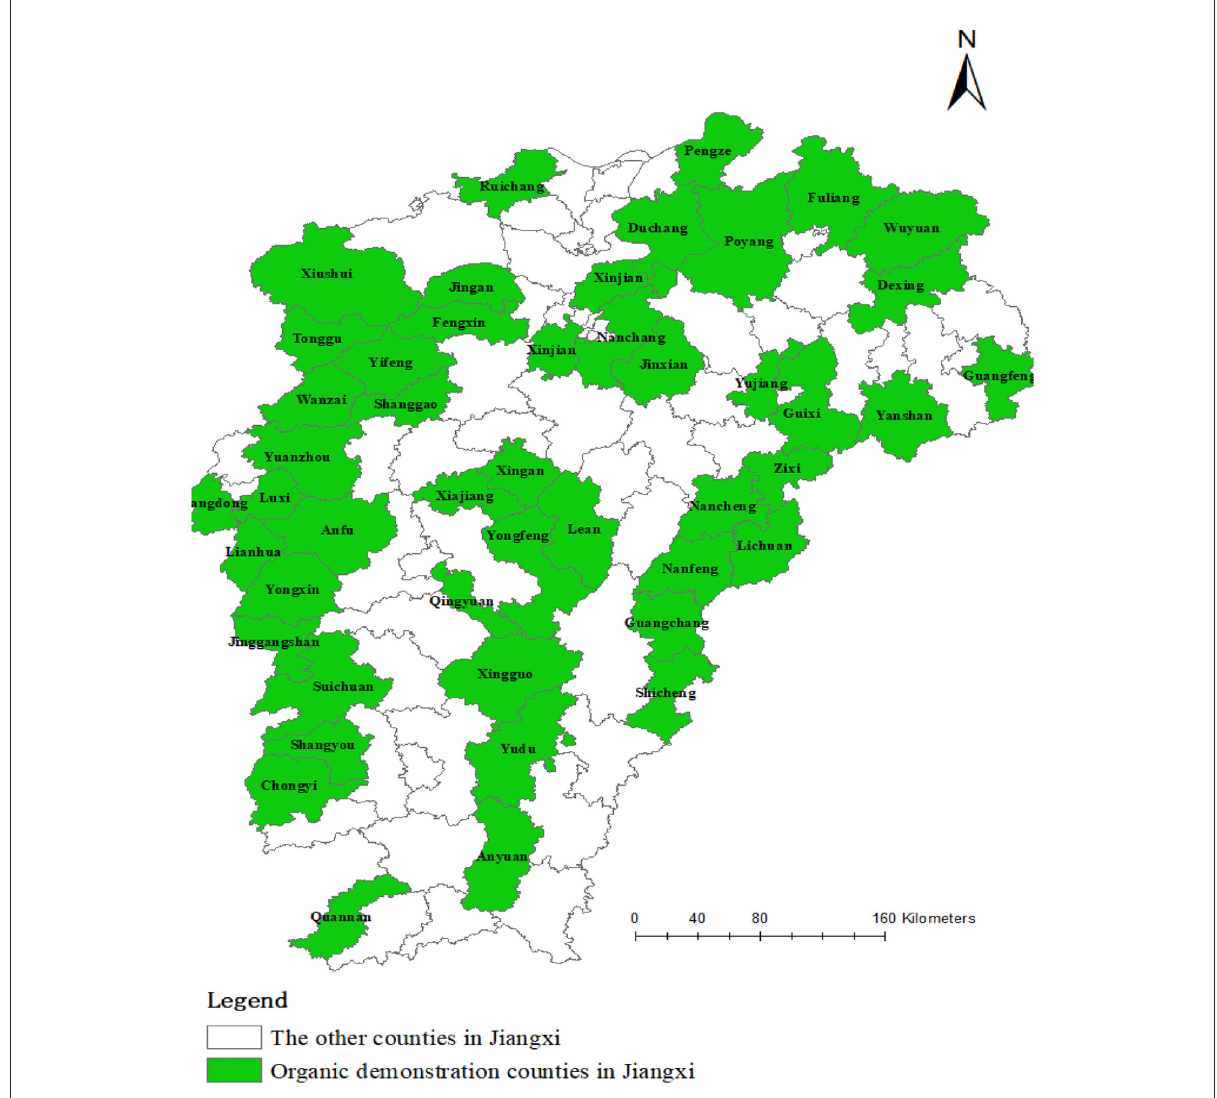
FIGURE2 Demonstration counties of organic food in Jiangxi